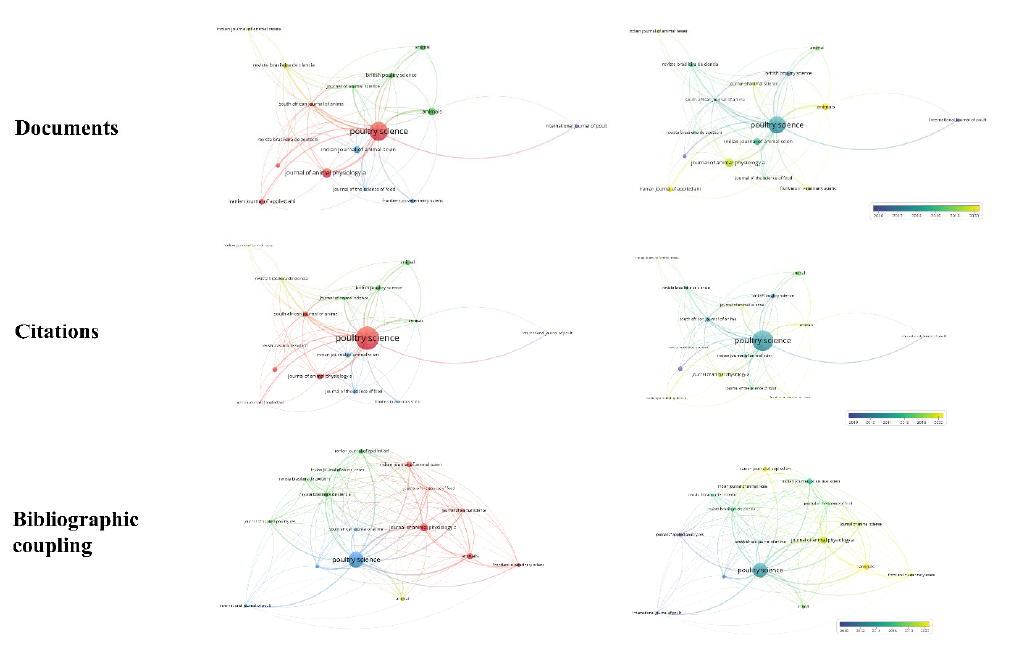
Figure 10. Network of journals based on numbers of documents, citations, and bibliographic coupling. Table 3. The 10 journals that published the most articles between 1985 and 2023.